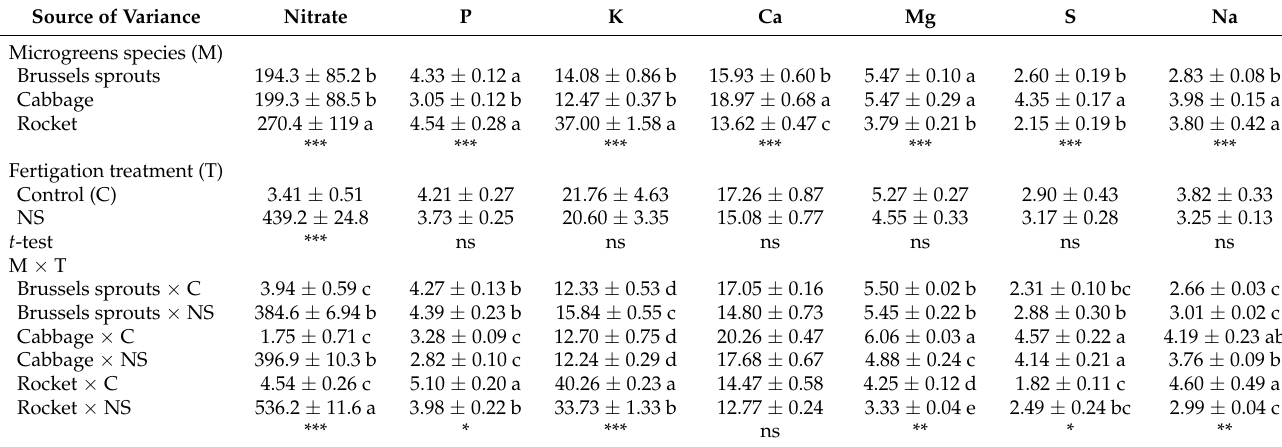
Table 2. Nitrate (mg kg − 1 fw) and mineral (mg g − 1 dw) content of Brussels sprouts, cabbage and rocket microgreens in light of the nutrient solution